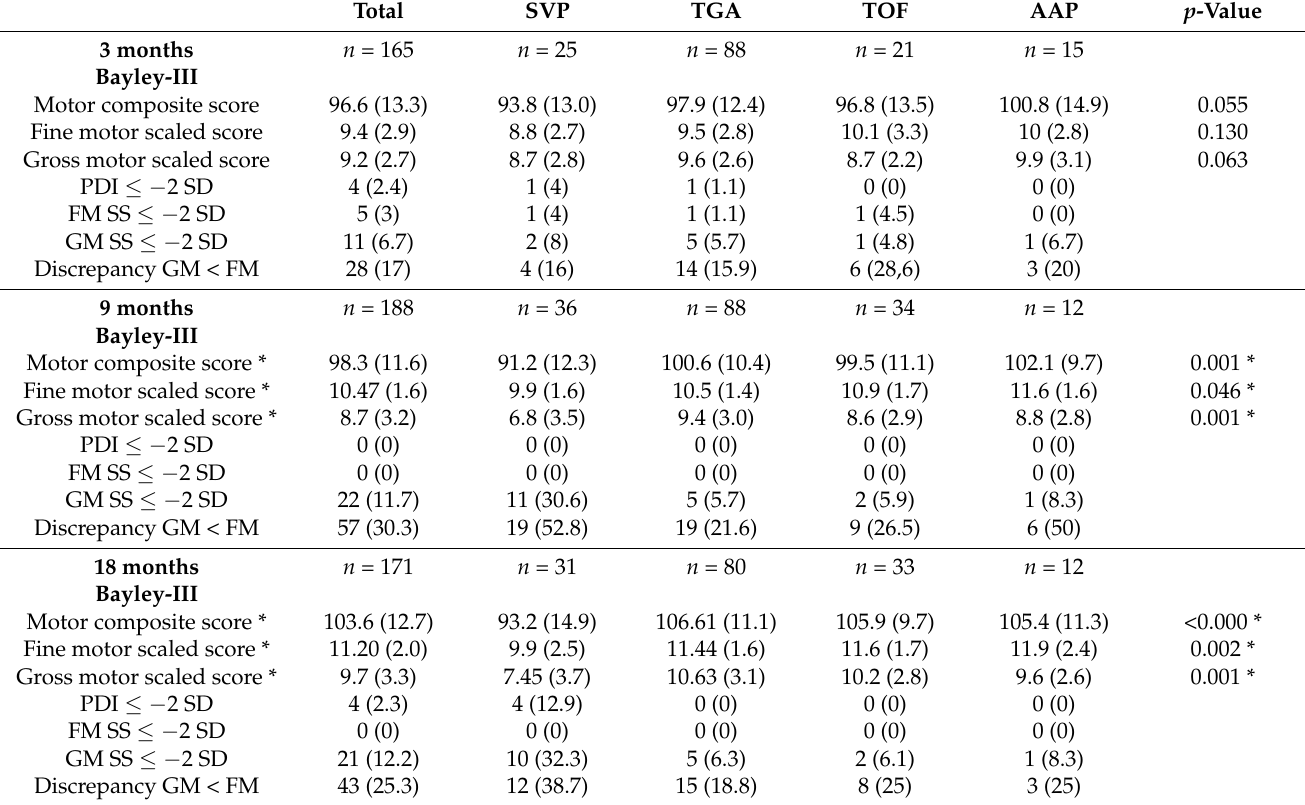
Table 2. Motor outcomes of infants and children with a CCHD at 3, 9, and 18 months: A comparison between single-ventricle physiology (SVP) and other diagnosis groups.